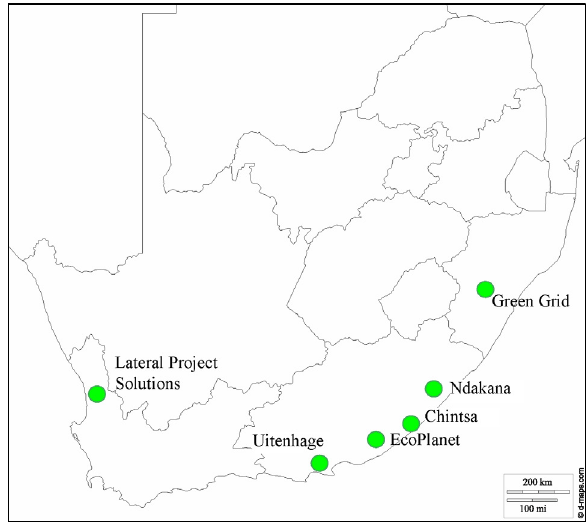
Map of commercial bamboo projects and activities in South Africa.